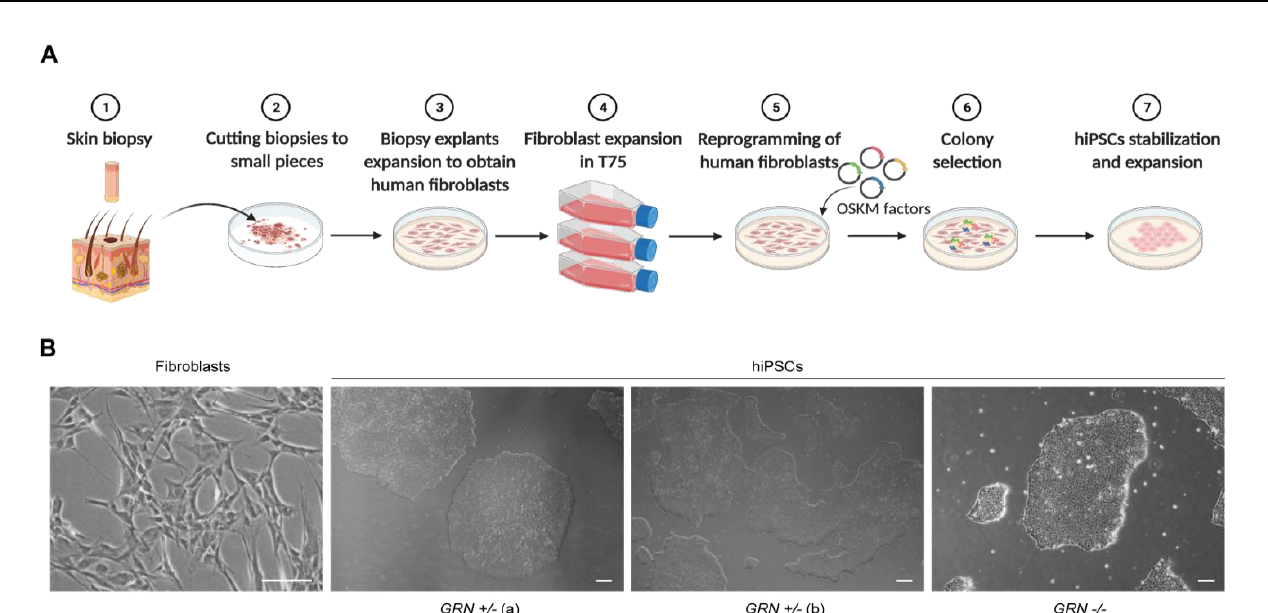
Figure 2. Generation and characterization of patient-derived hiPSCs . hiPSCs were generated from skin fibroblasts of three individuals, from the same family, all carriers of the progranulin mutation